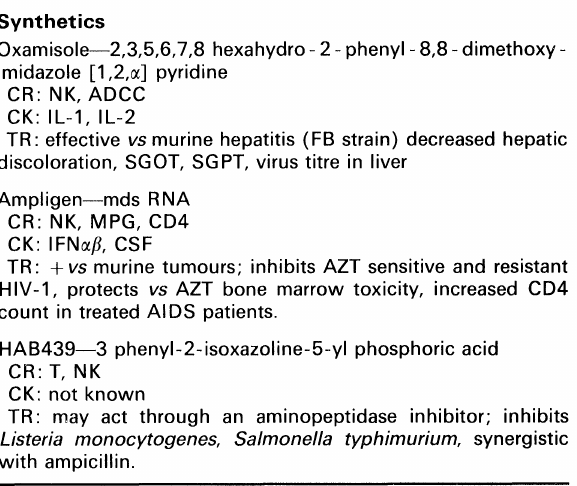
Table 10. Biological response modifiers of various origin